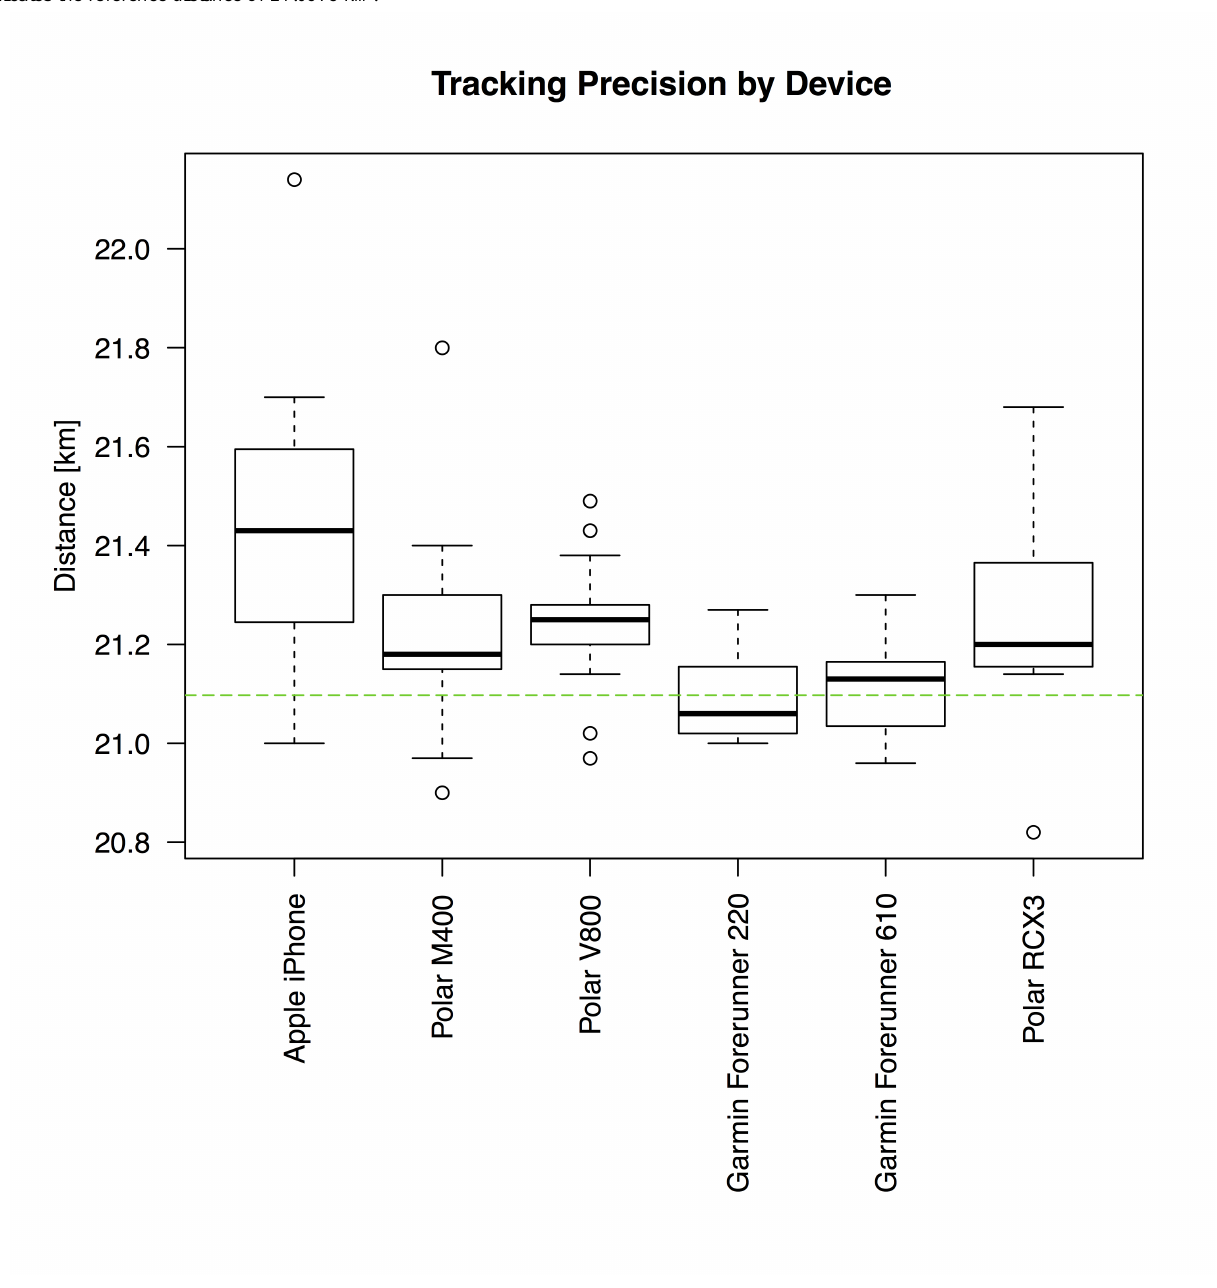
Figure 3. Box-and-whisker plot of recorded distances (half-marathon) by device: Apple iPhone (n=20), Polar M400 (n=36), Polar V800 (n=21), Garmin Forerunner 220 (n=7), Garmin Forerunner 610 (n=7), and Polar RCX3 (n=7). Devices with less than 7 measurements were omitted. The dashed line indicates the reference distance of 21.0975